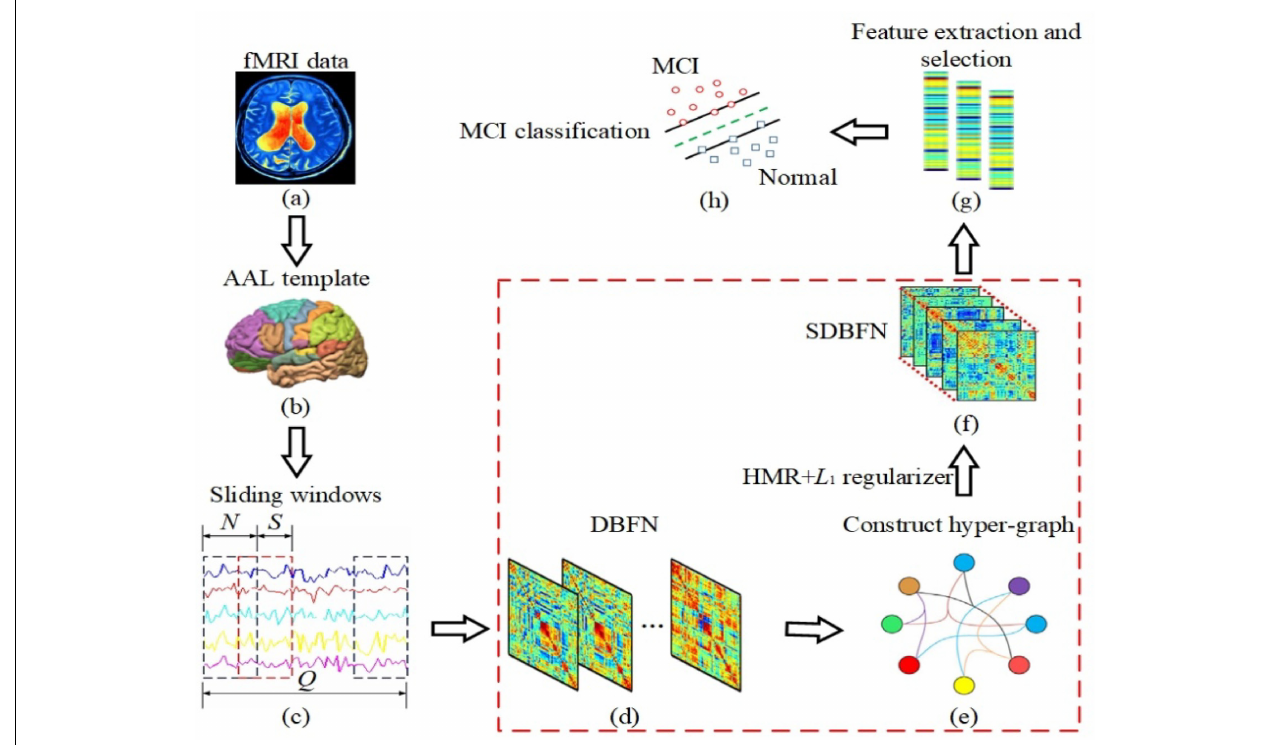
FIGURE 1 | The framework of constructing SDBFNs via SHMR for MCI classification. The area marked in red box is the key research part. (a) Preprocessing the obtained resting-state fMRI data of two types of subjects; (b) registering the preprocessed resting-state fMRI data to 90 brain regions according to the AAL template, and obtaining the time series of all brain regions; (c) dividing the entire time series into multiple overlapping sub-sequence segments by sliding window method; (d) constructing DBFNs based on the PC method and transforming it into an optimized model; (e) constructing hyper-graphs based on DBFNs and obtaining hyper-graph Laplacian matrices; (f) constructing the manifold regularizer by hyper-graph Laplacian matrices, and introducing the manifold regularizer and L 1-norm regularizer into the optimization model of the PC method to obtain SDBFNs; (g) extracting the weighted-graph local clustering coefficient of each brain region in SDBFNs, and using the t -test for feature selection; and (h) training a linear kernel SVM classifier to classify the SDBFNs of all subjects and analyzing the classification